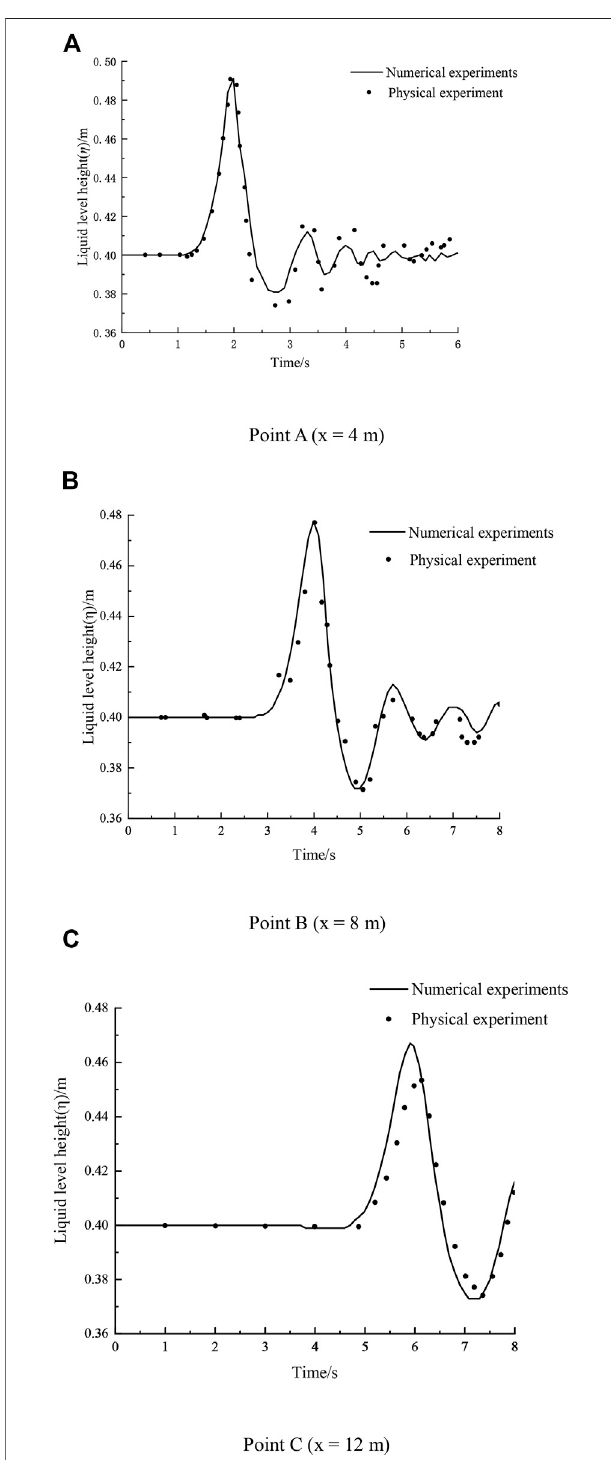
FIGURE 2 | Comparison of liquid surface levels at different locations. (A) Point A (x (cid:1) 4 m), (B) Point B (x (cid:1) 8 m), and (C) Point C (x (cid:1) 12 m).